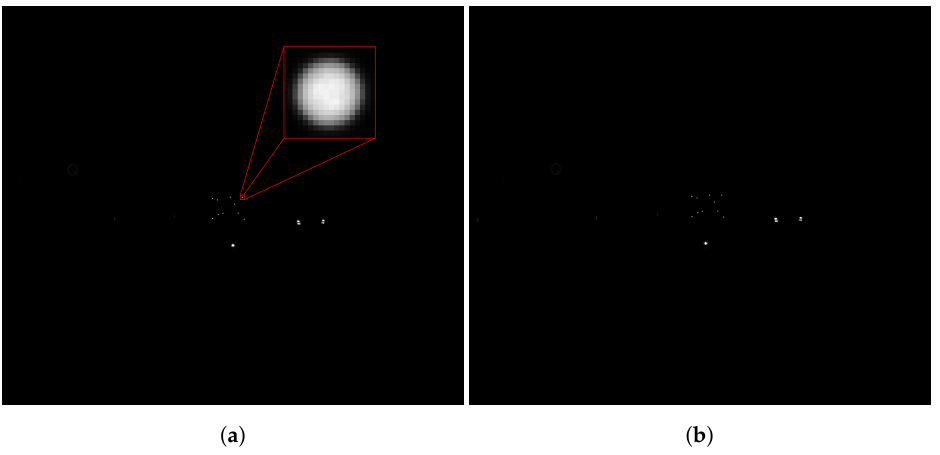
Figure 13. Left ( a ) and right ( b ) images of a stereo image pair of the test measurement. Object at 45m distance with additional interfering light in the scene. A zoom (red) shows the original resolution of an imaged LED